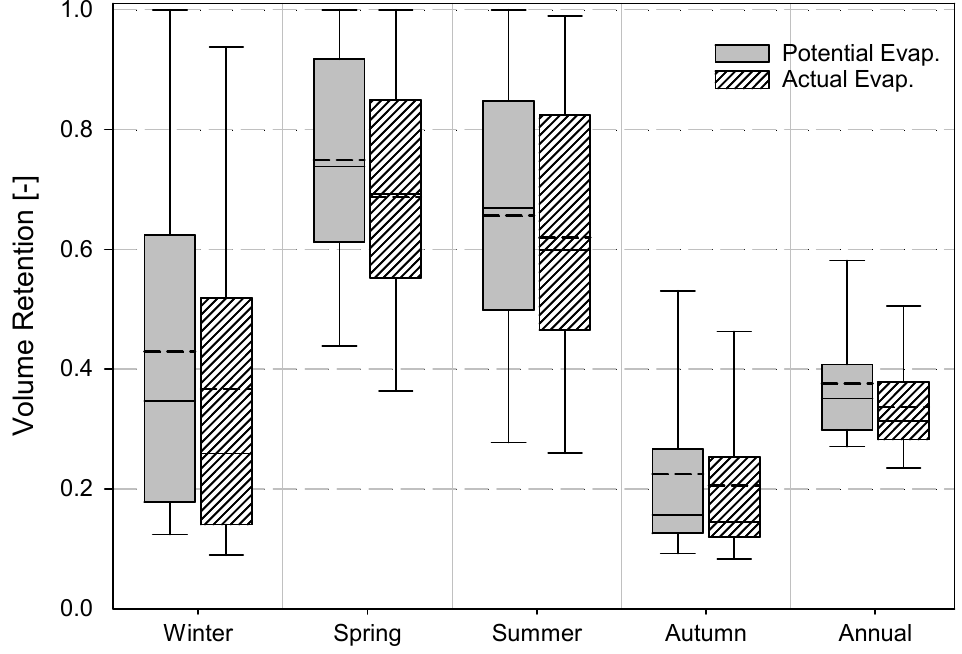
Figure 3. Non ‐ parametric distribution of the volume retention rate simulated assuming the potential (grey box) and actual (hatched box) evapotranspiration on seasonal and annual basis at the single green roof scale. The solid and dashed lines within the box mark indicate the median and mean values, respectively.